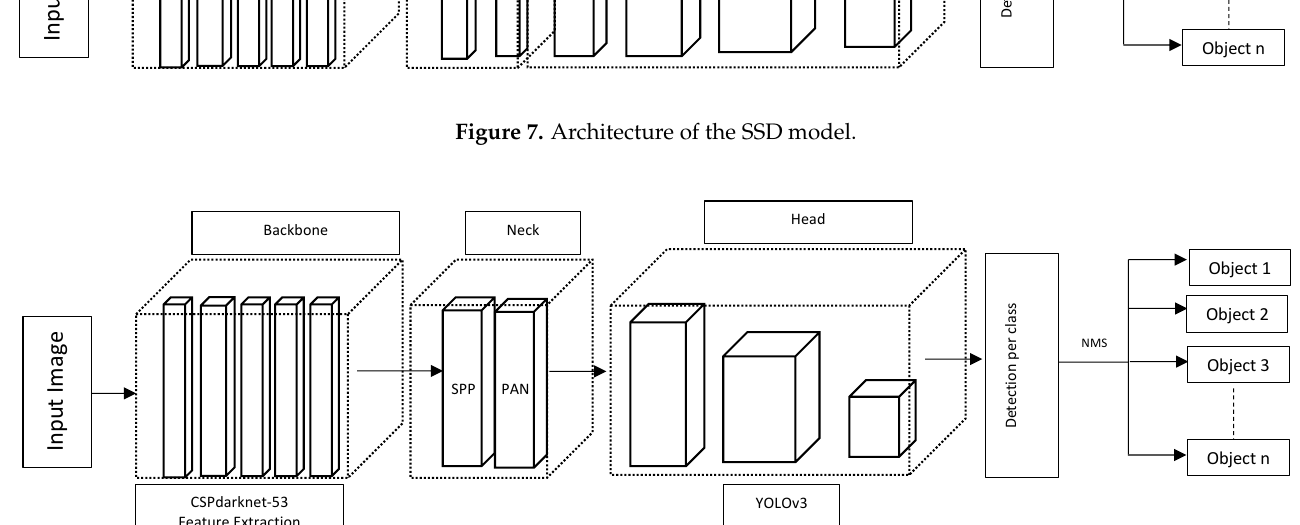
Figure 8. Architecture of the YOLOv4